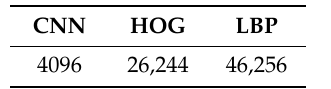
Table 4. Average time to process each image. Time